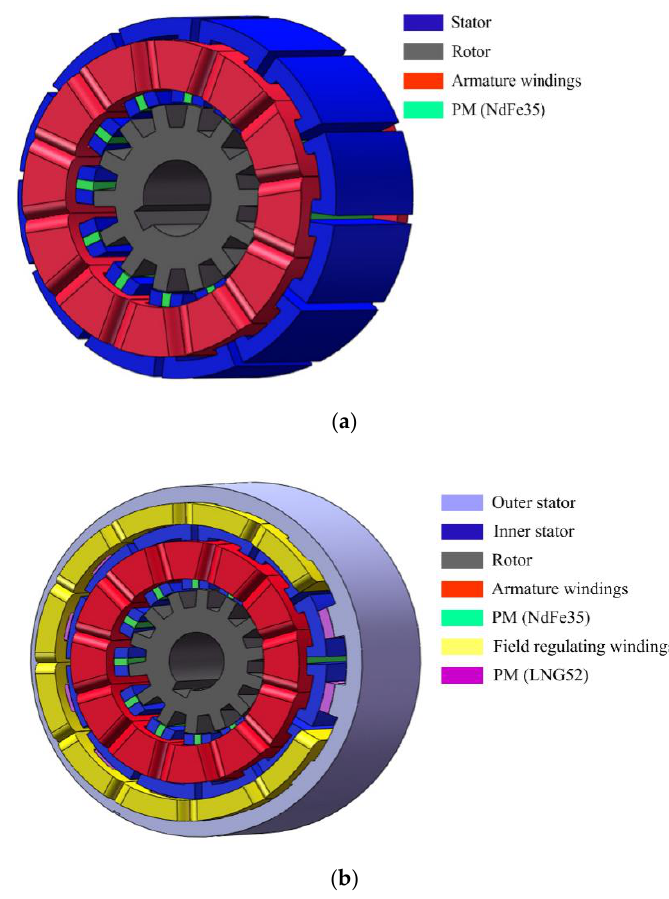
Figure 1. Two kinds of flux switching machines. ( a ) FSPM machine; ( b ) VFMPM machine.